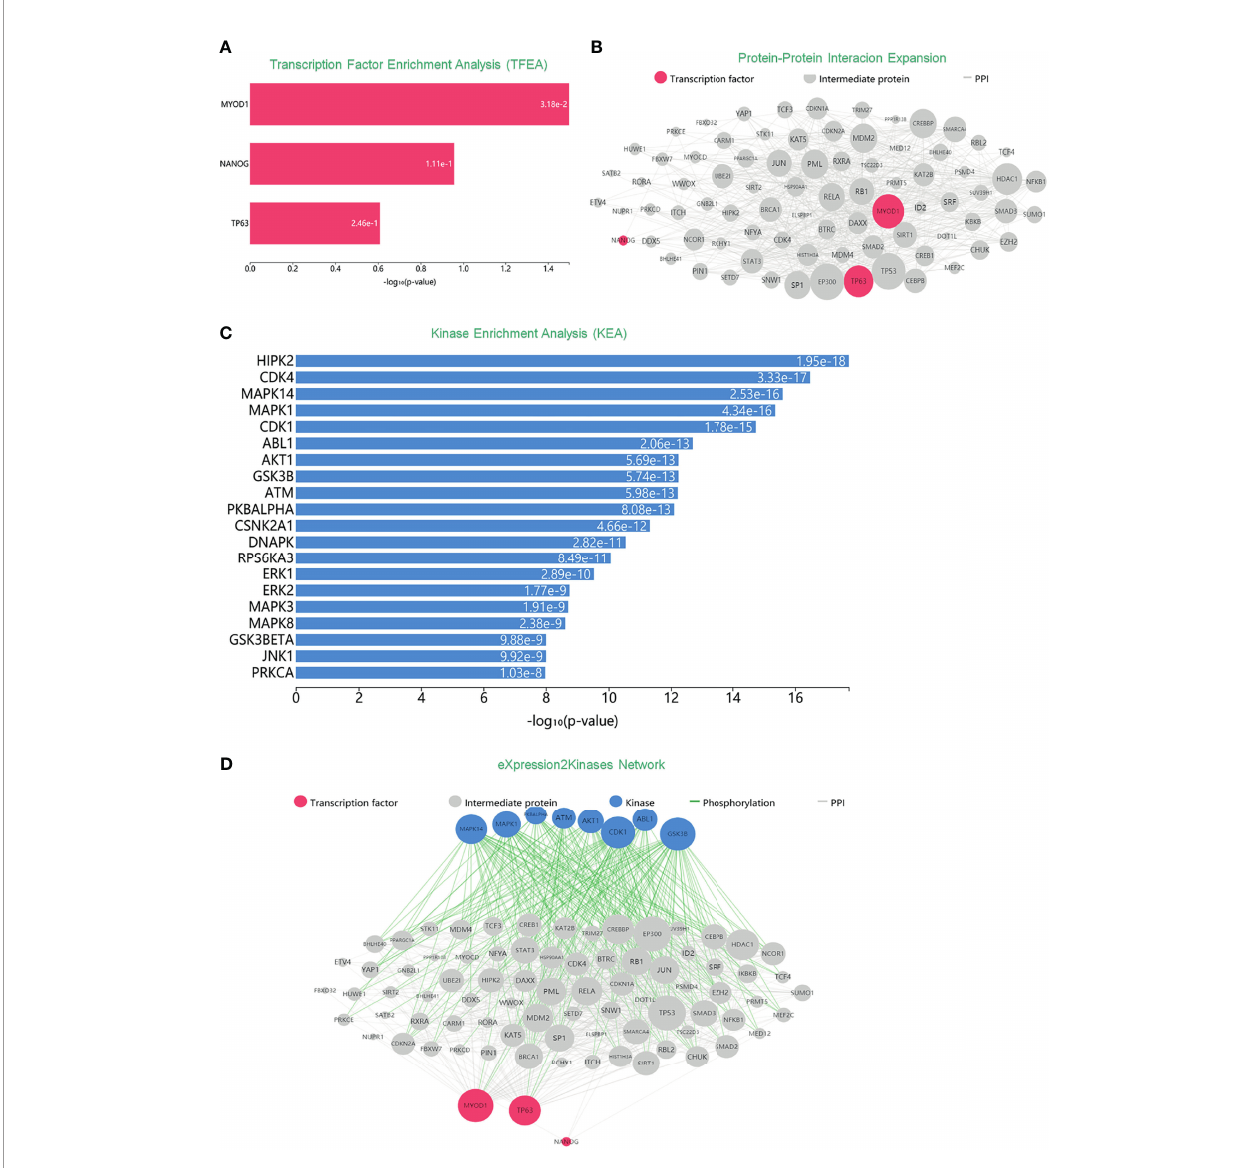
FIGURE 3 | Inferred upstream regulatory networks of DEGs. (A) TFEA was used to predict TFs. Top predicted TFs (MYOD1, NANOG, and TP63) are displayed as a bar graph. (B) PPI expands the list of enriched TFs. Gray edges indicate the interaction between two proteins. The size of nodes is relative to the level of expression degree. (C) KEA predicts the protein kinases that are likely the regulators of the expanded PPI network. (D) The eXpression2Kinases network displays the inferred upstream regulatory network of the